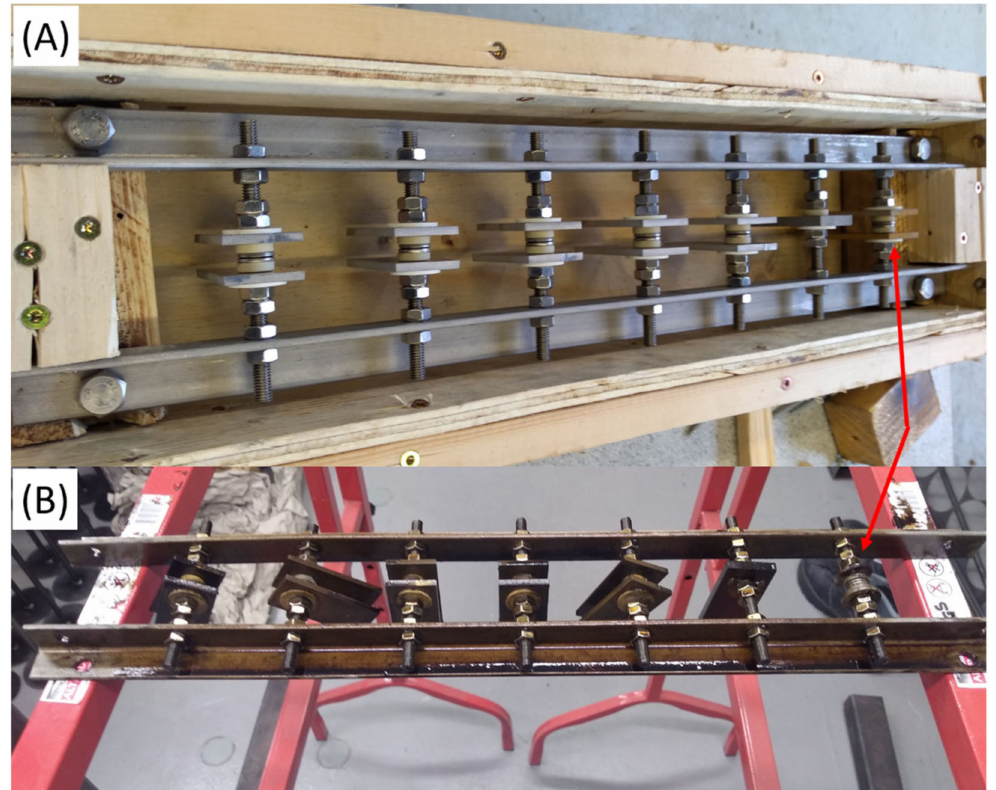
Figure 4. ( A ): The samples on a rack which was inserted into an oil flowline at Chaunoy. ( B ): The rack and samples after testing had been conducted. It is interesting to note that two carbon steel coupons, which are not investigated in this work, had corroded severely, and fallen off of the threaded rod during exposure as marked with red arrows.